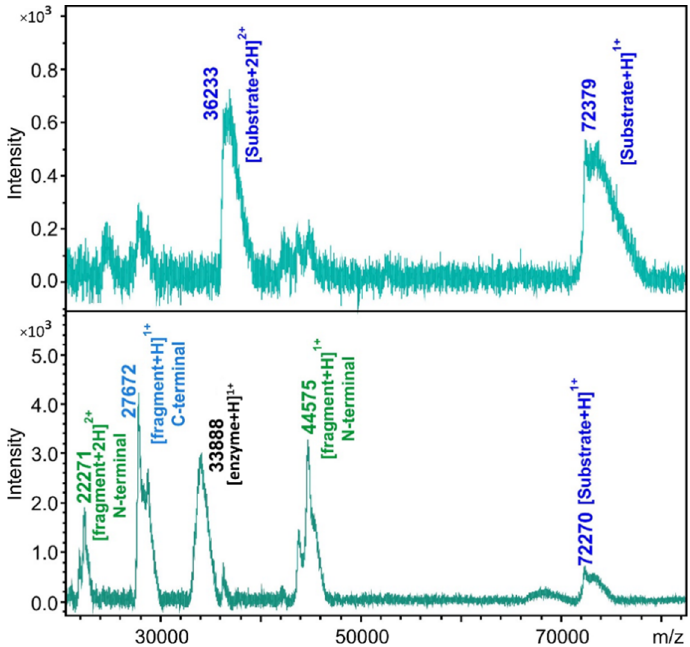
Figure 4. Cleavage site determination by MALDI-TOF MS. The representative spectra show the analysis of the substrate control ( upper panel ) and cleavage reaction ( lower panel ) in the case of His 6 -MBP-mEYFP substrate containing the SAE2 cleavage site.